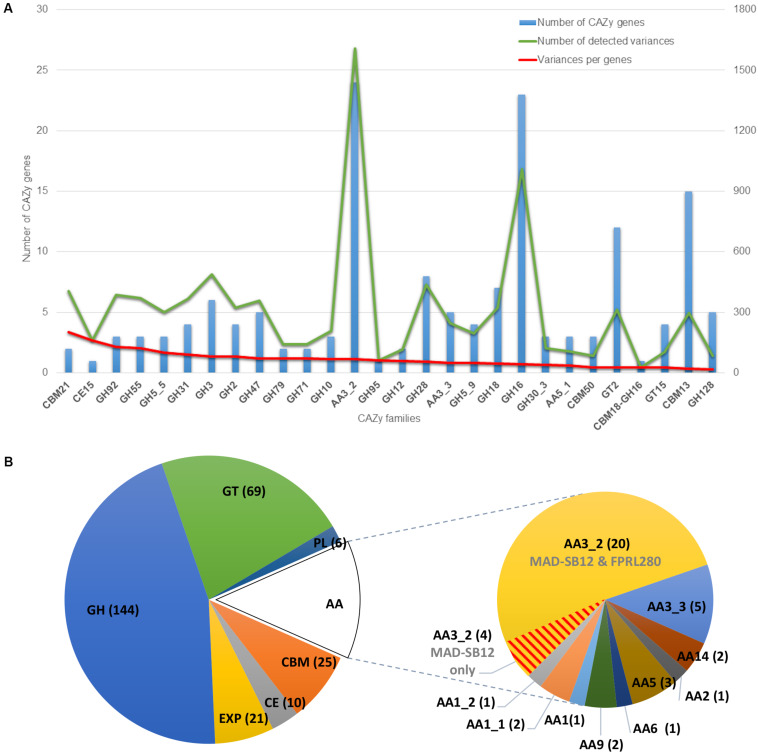
CAZy classification. (A) Variant analysis of CAZy genes of FPRL280 compared to MAD-SB12 (only CDS). The graphic only shows CAZy families mentioned in the text, a graphic with results for all CAZy families can be found as Supplementary Figure 1. The blue bar shows the number of CAZy genes with variants within the CAZy subfamilies. The green line shows the number of all variants occurring in the CAZy subfamilies. The red line shows the variances within the CAZy subfamilies normalized to their size. (B) Entire classification of CAZy-encoding genes in both genomes, highlighting class AA, with the subfamily AA3_2, in which many variants were found and four genes were missing in FPRL280 vs. MAD-SB12 (red line pattern). The piecharts contain CAZy families AA, CBM, CE, GH, GT, and PL, as well as expansins (EXP).